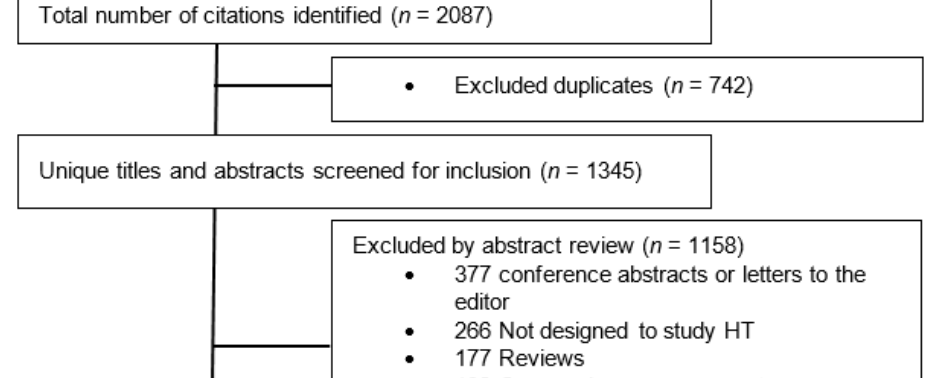
Table 1. Prevalence (%) of hemorrhagic transformation.